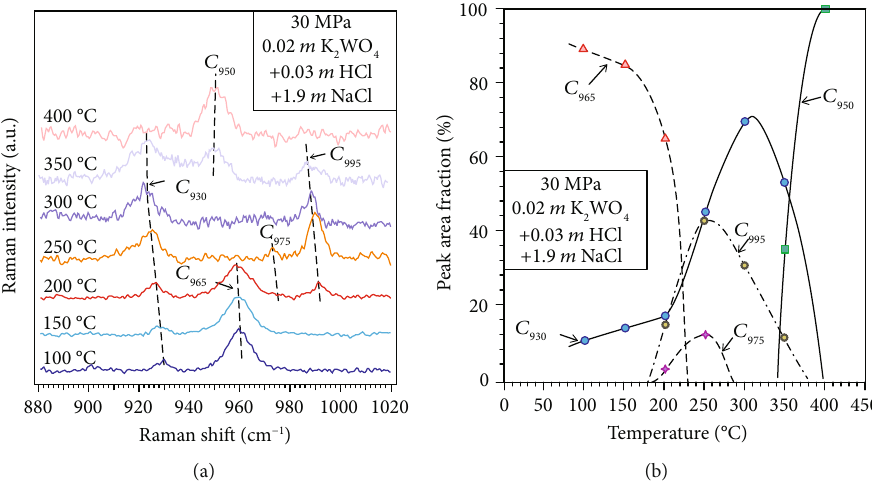
Figure 4: (a) In situ Raman spectra of 0.02 m K WO +0.03 m HCl+1.9 m NaCl solution at 100 – 400 ° C and 30MPa; (b) peak area fractions of 2 4 di ff erent v 1 (W=O) bands as a function of temperature for the solution shown in (a). It should be noted that the lines in the fi gure are used to show the general variation trend of the peak area fractions. Data plotted are those listed in Table 2.